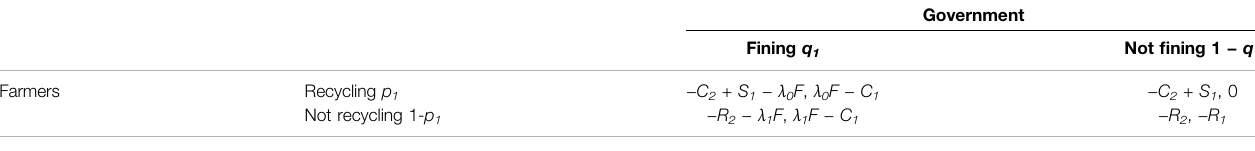
TABLE 1 | Game revenue matrix between farmers and government under the intervention mechanism of punish.